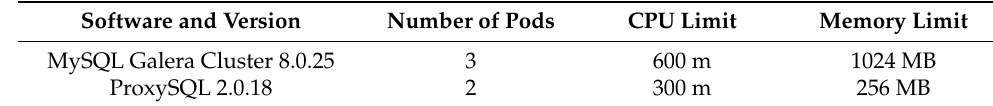
Table 1. Software Versions and Resource Allocation.